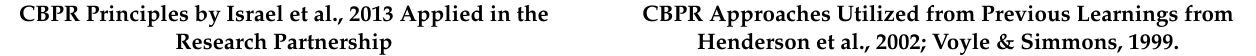
Figure 2. Key steps for formative and process evaluation of a community development partnership. Adapted from Voyle & Simmons, 1999. Table 1. Community Based Participatory Research (CBPR) principles utilised in the community engagement process with the Australian Samoan